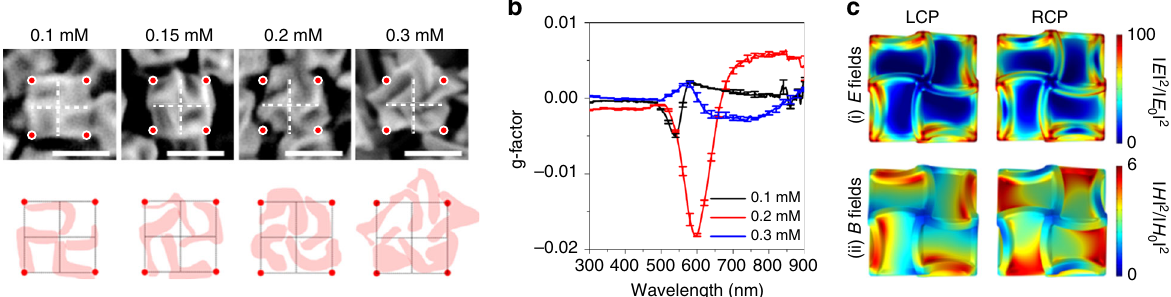
Fig. 4 Effect of the cysteine concentration on the chiral morphology. a SEM images of synthesized nanoparticles under different cysteine concentrations ranging from 0.1 to 0.3 mM. The cysteine concentrations used in the synthesis are overlaid on the SEM images. The particles are aligned with the same <100> orientation. The centerlines (white dashed lines) and corners (red dots) of the nanoparticles are displayed in the SEM images to clearly show the deviation of the edges from the centers. The highlighted edges of each nanoparticle are represented at the bottom of the SEM images, and the edge deformation is directly compared based on the same black standard lines. Scale bars, 100 nm. b The g-factor spectra of nanoparticles prepared under different synthesis conditions of 0.1 (black), 0.2 (red), and 0.3 mM (blue) cysteine concentrations. Error bars are included in the spectra based on the statistical analysis over four different sample batches. Mean ± s.d. ( n = 4) is shown. c Theoretical calculation of the electric (E, (i)) and magnetic fi eld (B, (ii)) intensities of the 0.1 mM case of helicoid IV. Different fi eld distributions are generated depending on the left circularly polarized (LCP) and right circularly polarized (RCP) light at 580 nm wavelength. Electric fi elds are expressed on a log scale, and magnetic fi elds are expressed on a linear